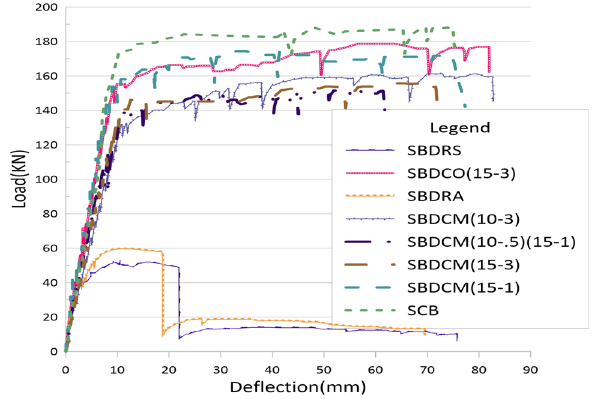
Fig. 11 Crack spread pattern of specimens corresponding to the fracture